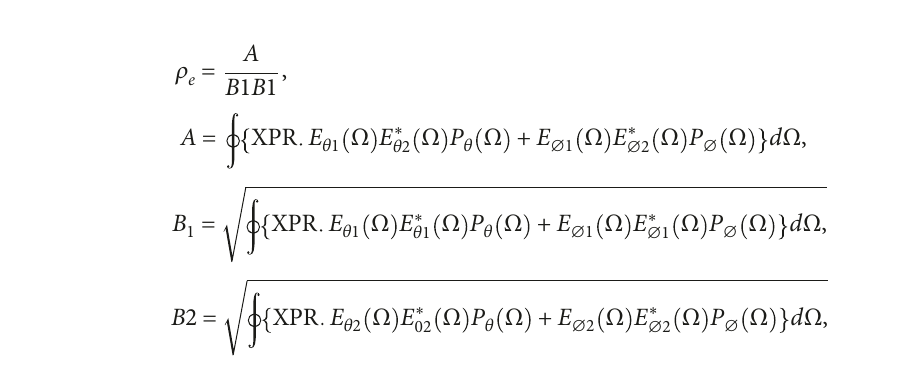
Figure 7: Peak gain of the proposed MIMO antenna.